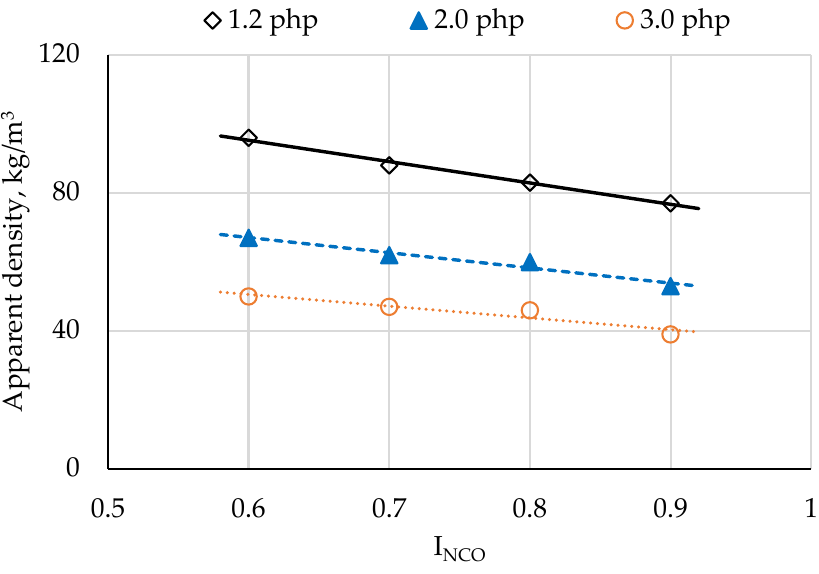
Figure 2. Apparent density depending on isocyanate index and water content.